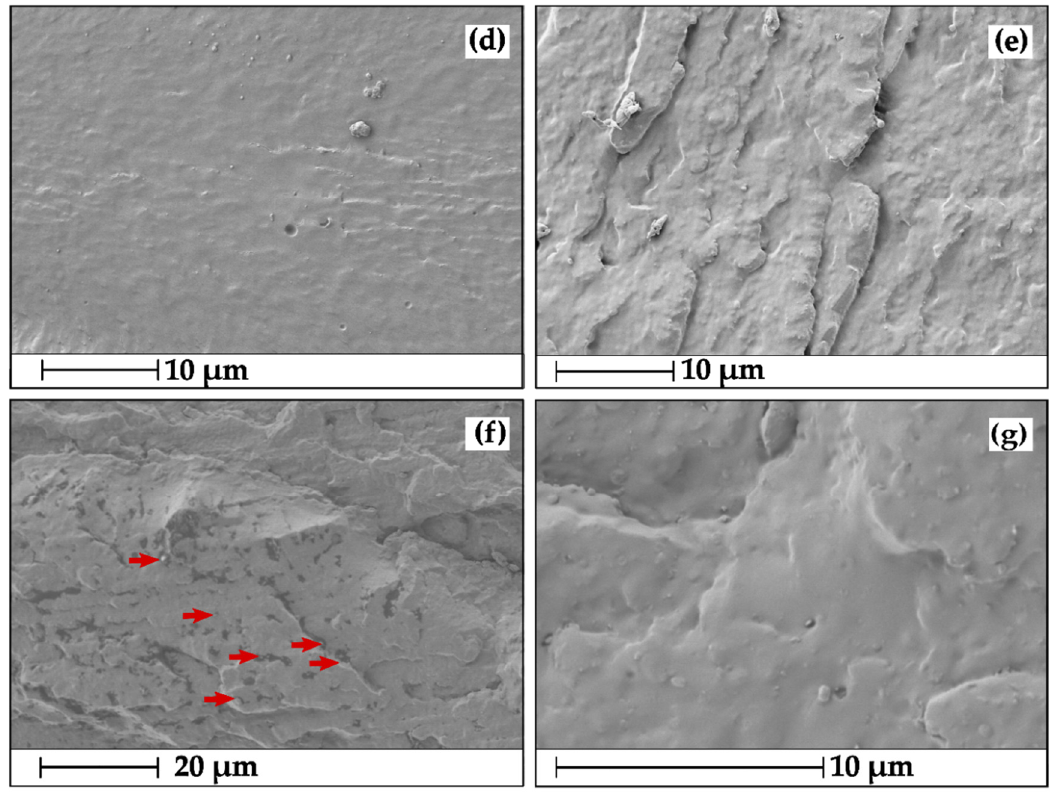
Figure 2. Scanning electron microscopy micrographs of ( a ) PBAT, ( b ) PBAT-5GR, ( c ) PBAT-5UT, ( d )